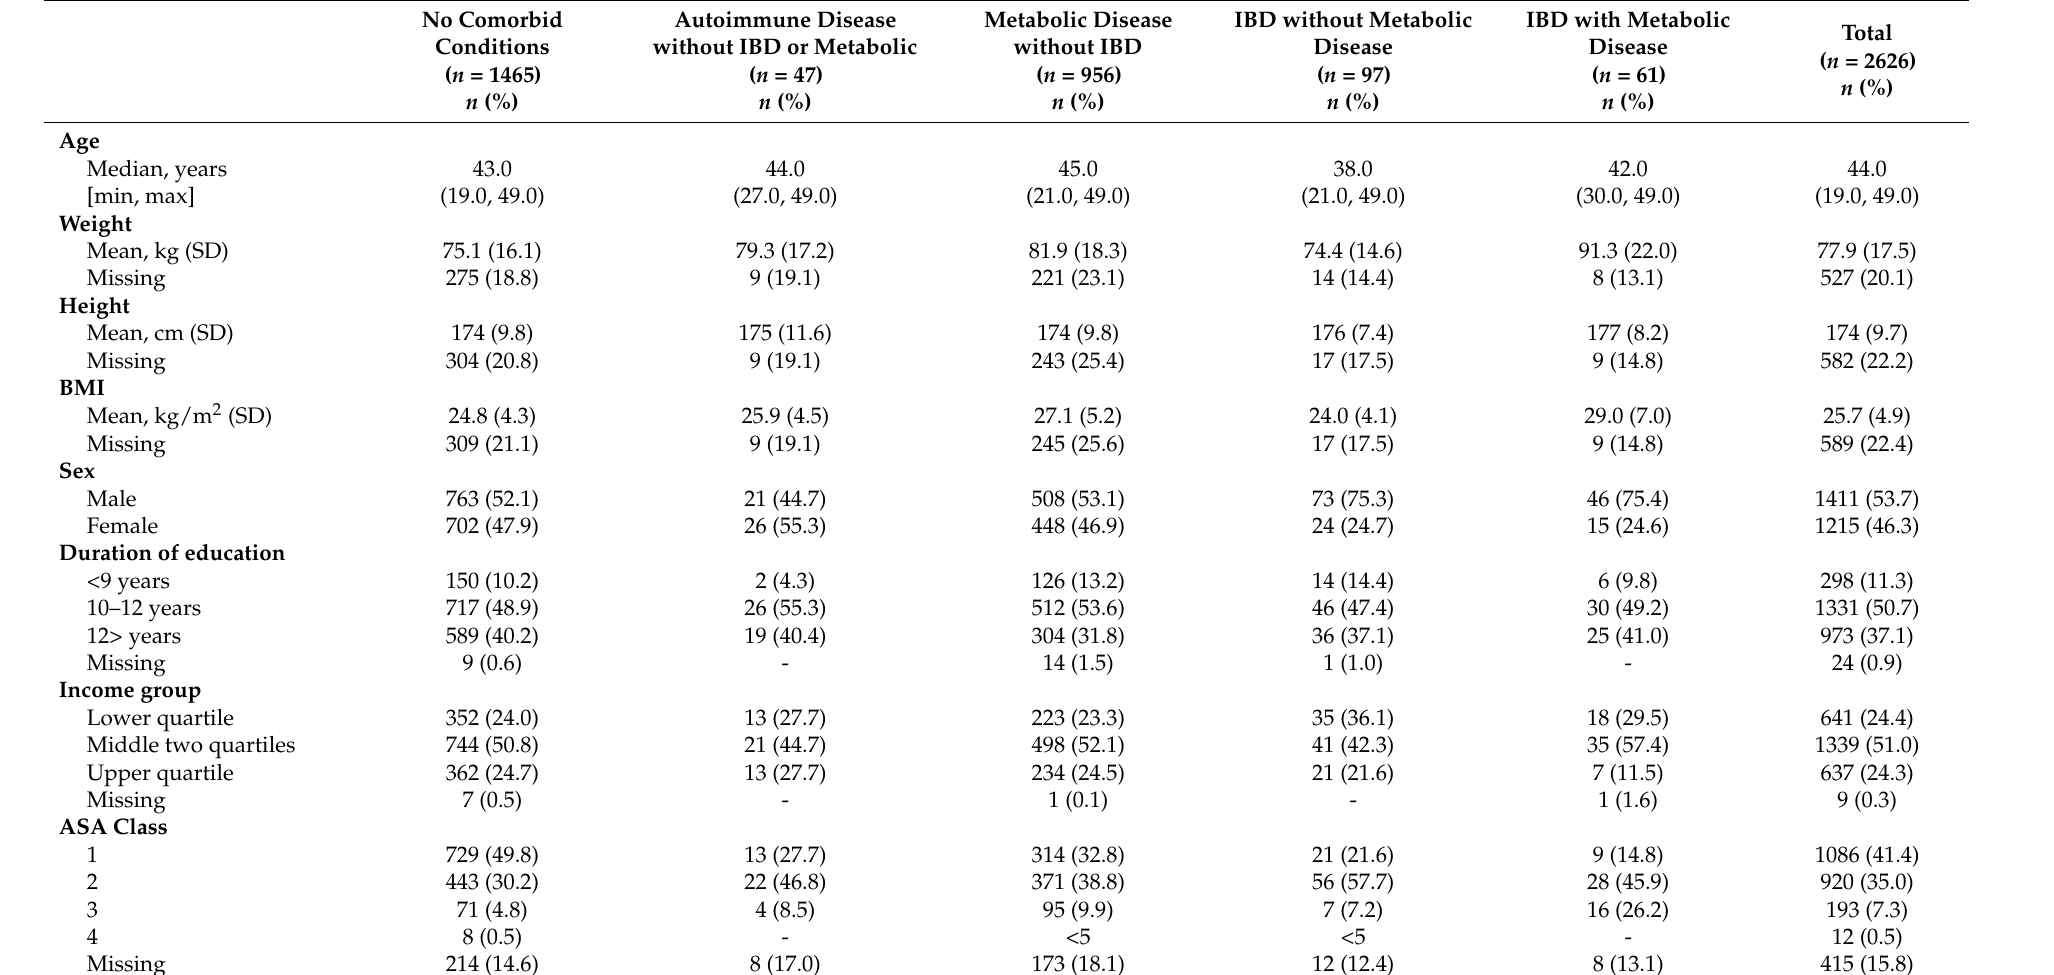
Table 2. Patient characteristics of Swedish early-onset colorectal cancer* (2007–2016), separated for concomitant comorbid